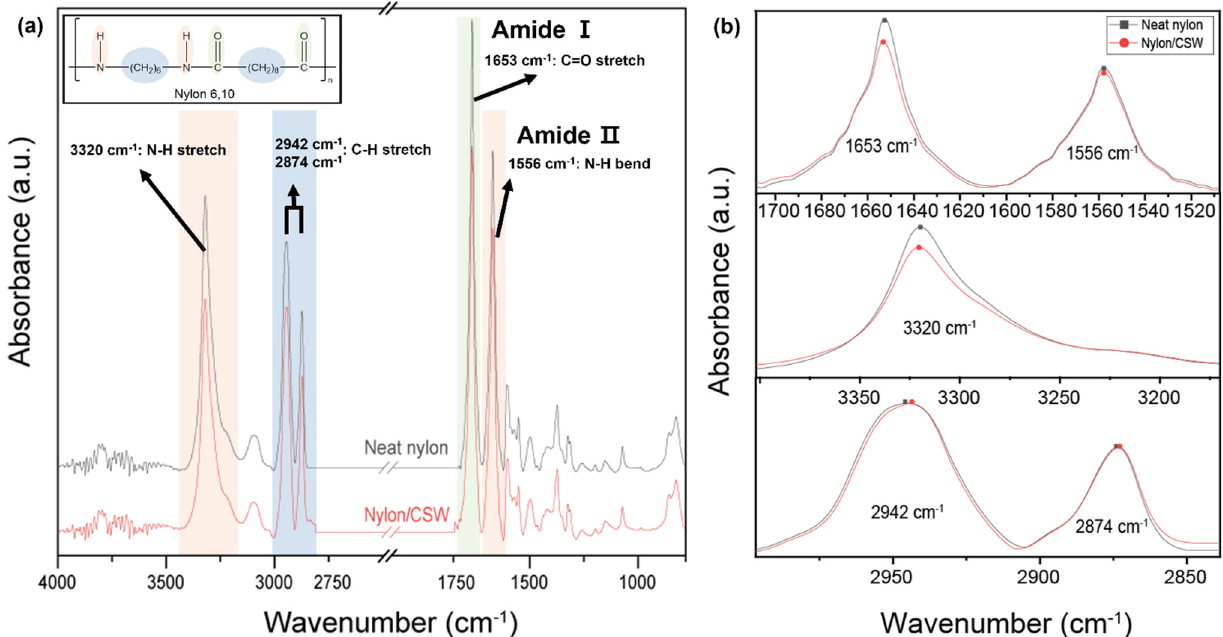
Figure 2. FTIR spectra of neat nylon and nylon/CSW nanocomposite (sample stirred for 1.5 h). ( a ) Full-range spectrum (600–4000 cm − 1 ) and ( b ) Enlarged view of amide I (1653 cm − 1 , C=O stretch) and amide II (1556 cm − 1 , N-H bend) bonds, N-H stretch (3320 cm − 1 ), and methylene groups (2942 and 2874 cm − 1 , C-H stretch).